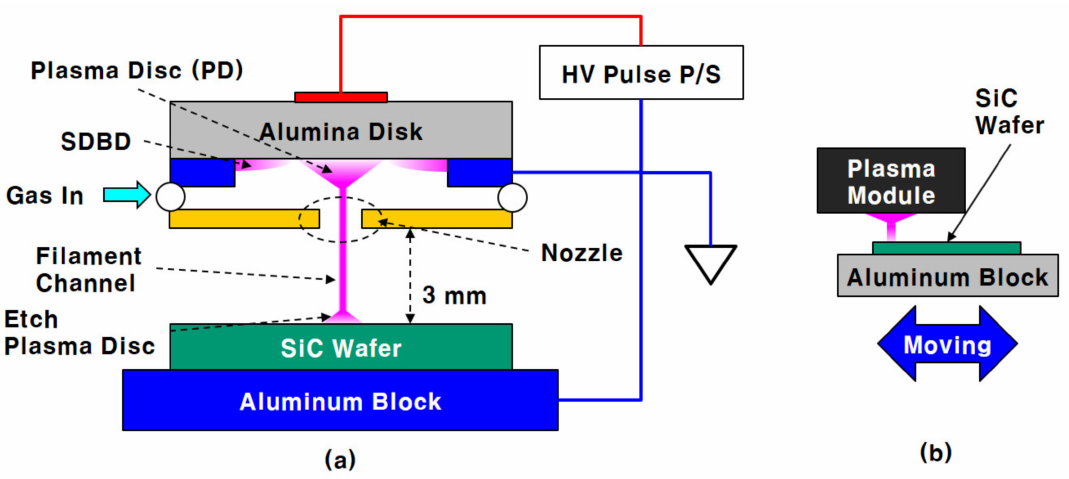
Figure 1. The experimental configuration ( a ) and the method of etch groove making ( b ).